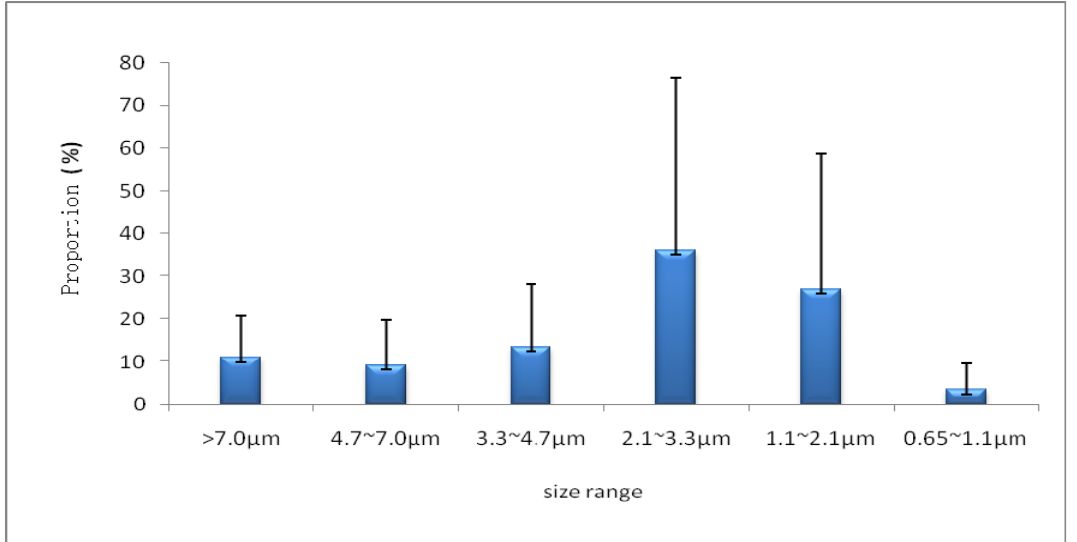
Figure 2. Average size distribution of airborne fungi during the CHINARE 2010. The error bars represent standard